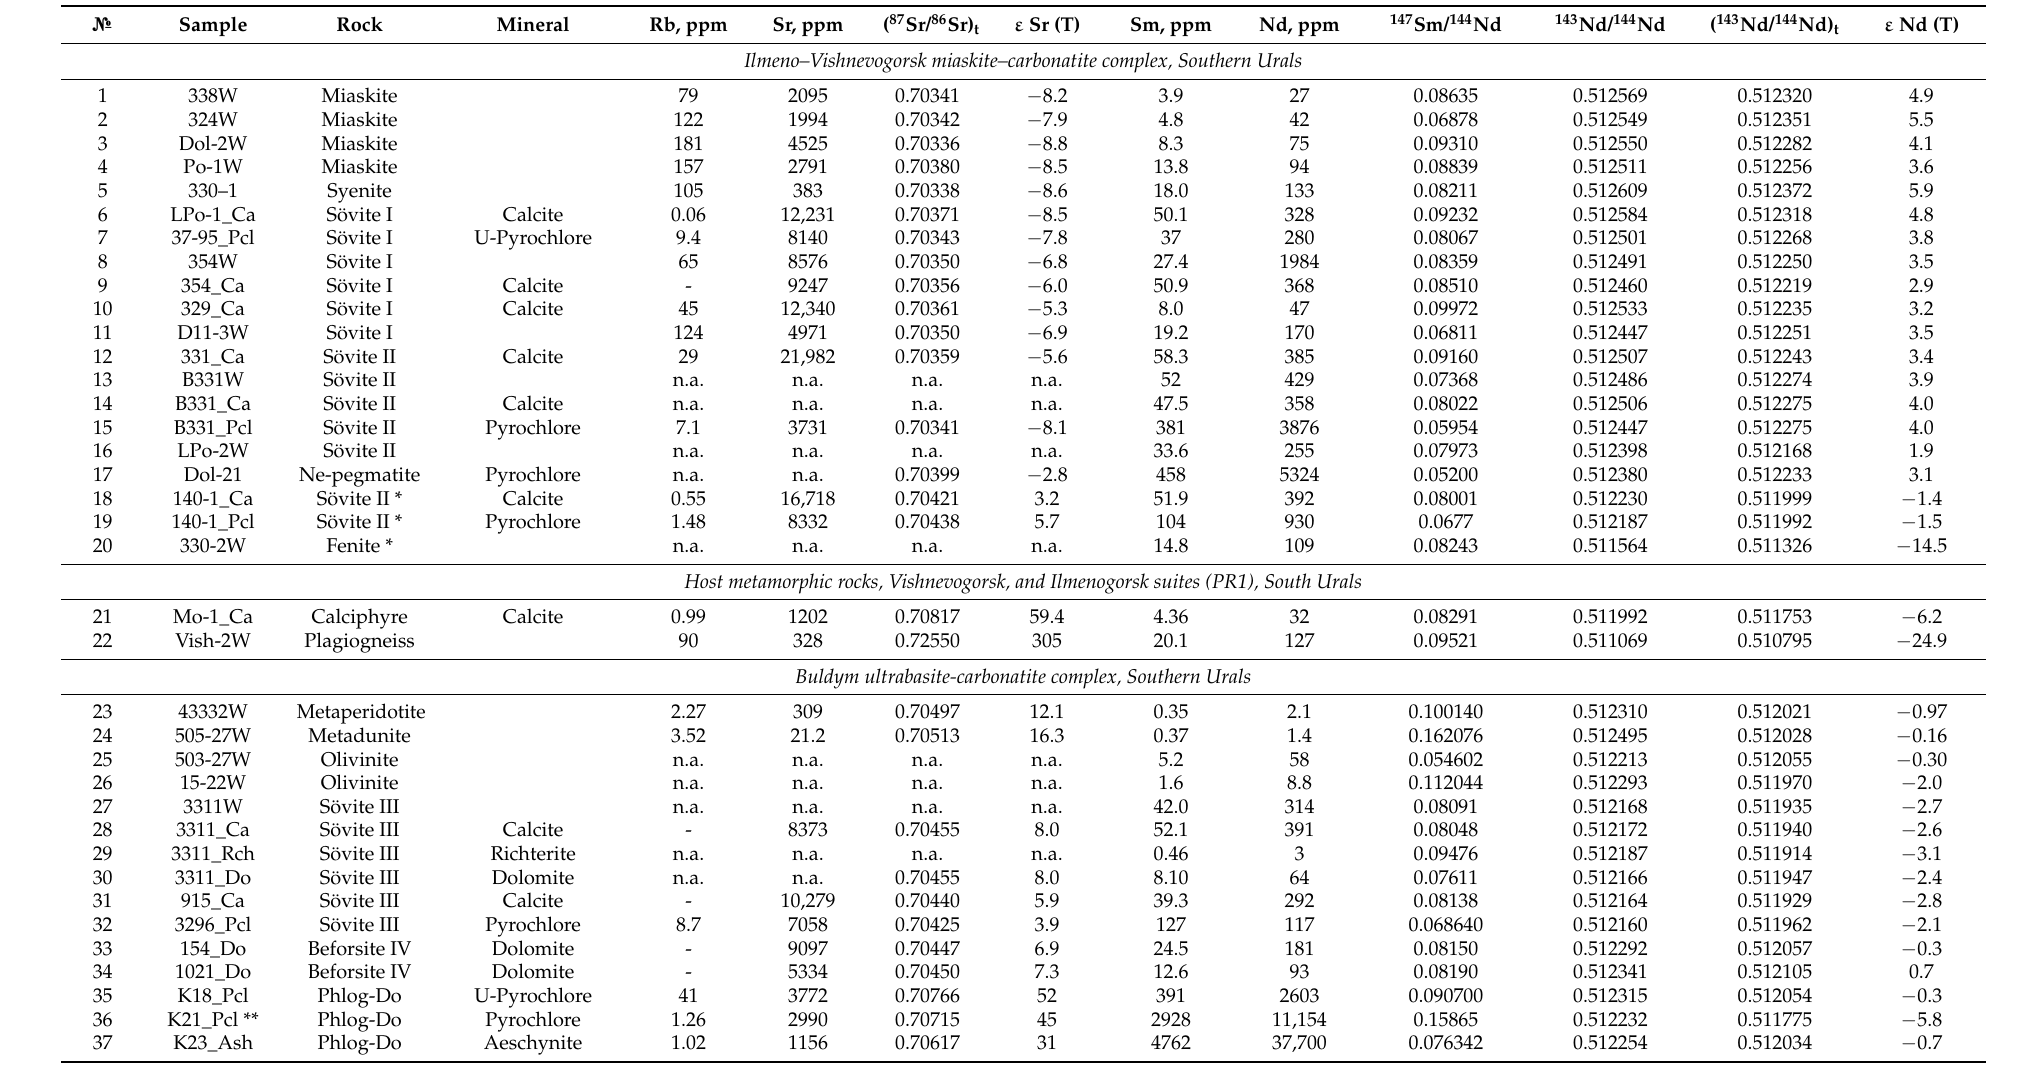
Table 5. Sm-Nd and Rb-Sr-isotope data for the rocks and minerals of carbonatite complexes of the Urals and